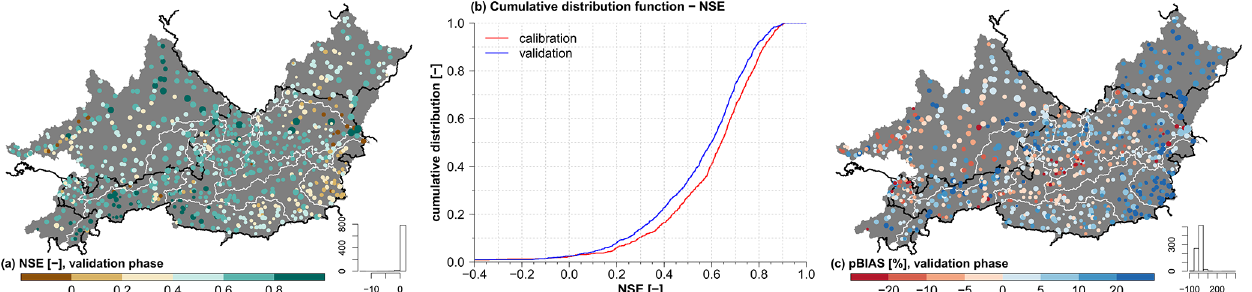
Figure 13. (a) Spatial distribution of NSE in validation phase. (b) Cumulative distribution of NSE in calibration and validation phase. (c) Spatial distribution of percent bias in validation phase (positive values indicate a simulated surplus). The size of the circles in plots (a) and (c) is proportional to the catchment area. © EuroGeographics for the administrative